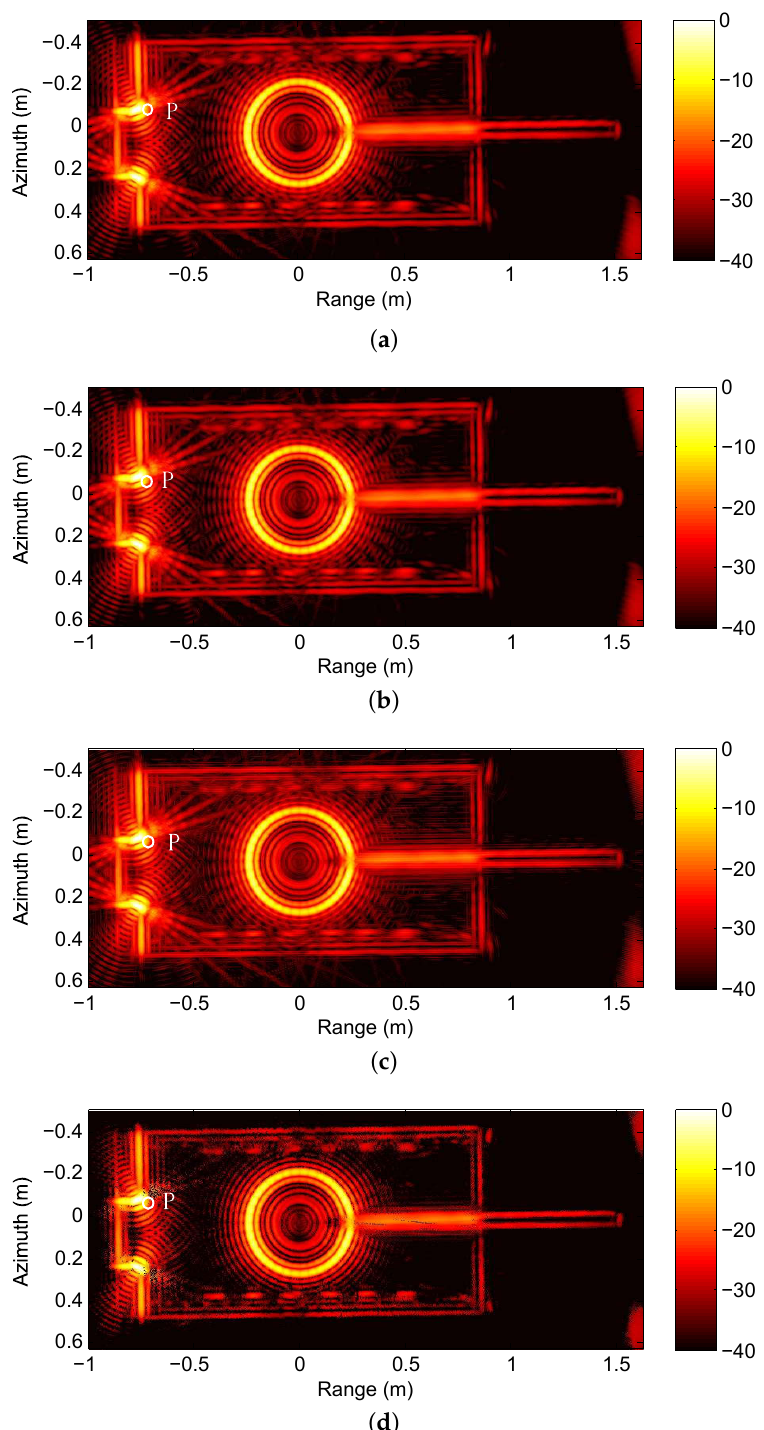
Figure 2. Results of the four methods. ( a ) GLRT result of BP; ( b ) GLRT result of CS; ( c ) GLRT result of debiased-CS; ( d ) GLRT result of